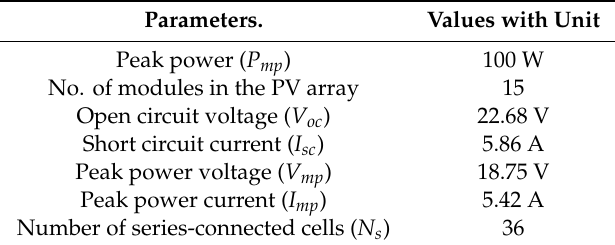
Table 1. Specification of the solar photovoltaic module.